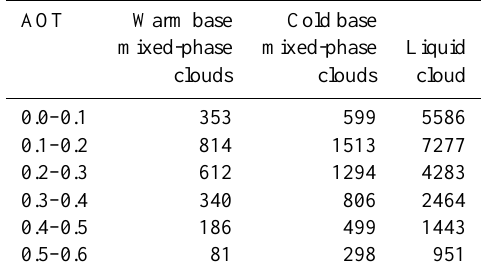
Table 4. Sample sizes for the data points in Fig. 1c and